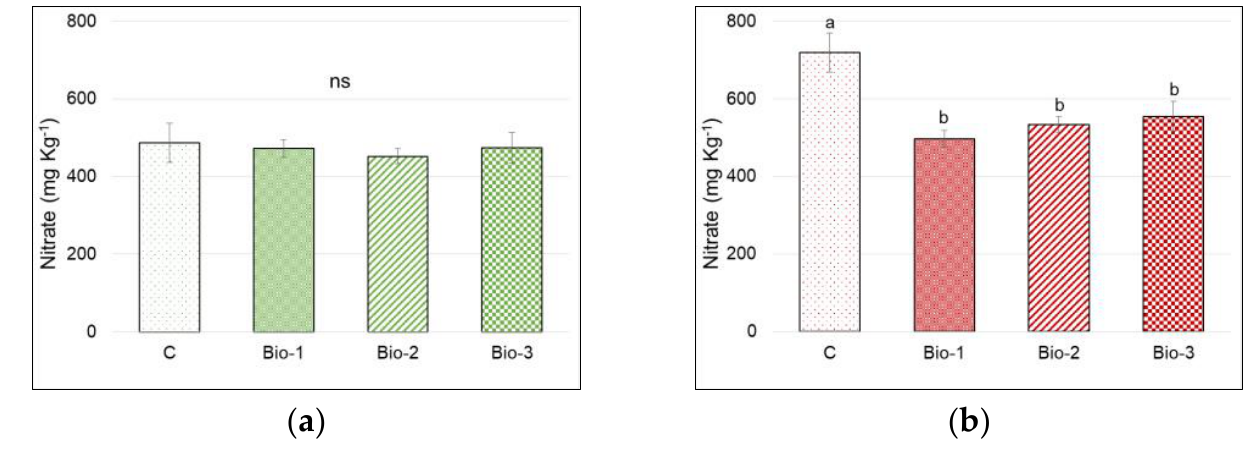
Figure 4. Effect of biostimulants (Bio-1 = TRAINER ® ; Bio-2 = AQUAMIN, and Bio-3 = Moringa oleifera leaf extract) on nitrates content (mg kg − 1 ) in turnip greens ( a ) and radish ( b ) microgreens. Data are means ± se ( n = 3). Different letters indicate significance at p ≤ 0.05 according to the LSD test.